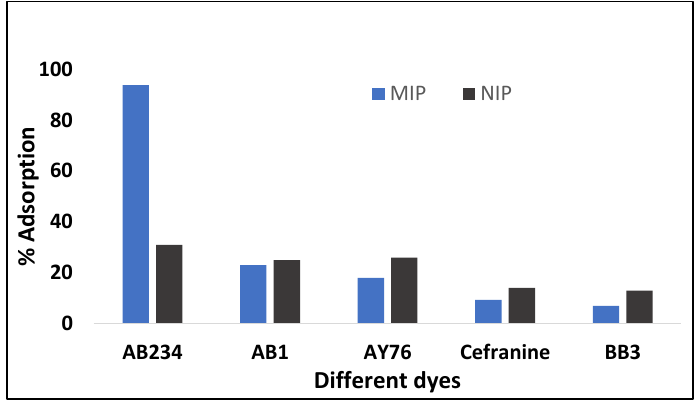
Figure 9. Selectivity of MIP towards different similar structures dyes .